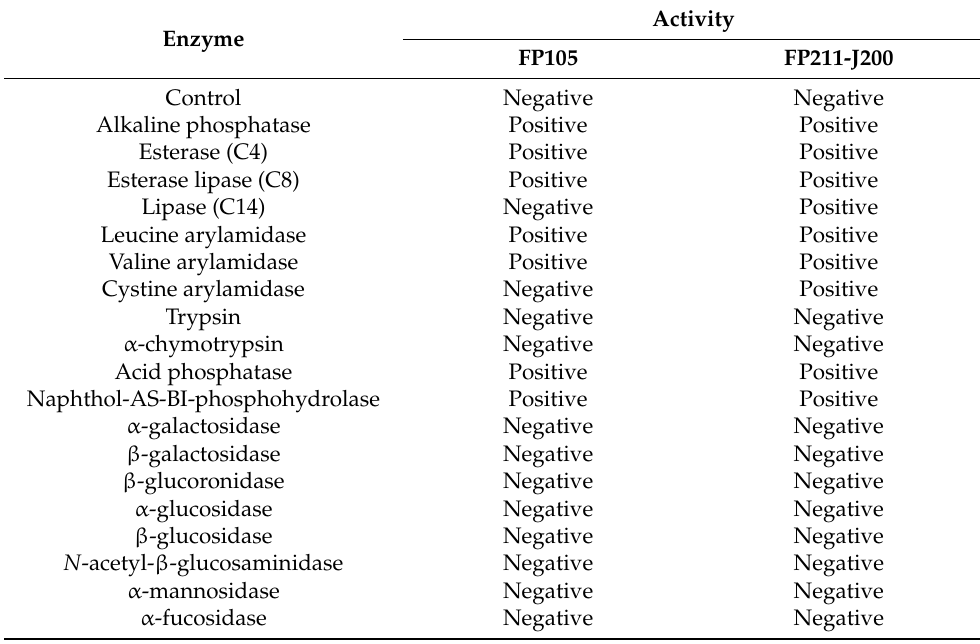
Figure 1. Colony morphotypes of the Epilithonimonas strains recovered from diseased rainbow trout from Chilean farms grown on TYES agar: ( A ) FP105; ( B ) FP211-J200. The API ZYM profiles of the FP105 and FP211-J200 strains are presented in Table 1, showing the capacity of both isolates to produce the enzymes alkaline phosphatase, esterase (C4), lipase (C8), leucine arylamidase, valine arylamidase, acid phosphatase, and naphthol- AS-BI-phosphohydrolase, whereas only FP211-J200 strain was able to produce lipase (C14) and cystine arylamidase. Table 1. Enzymatic properties of the Epilithonimonas FP105 and FP211-J200 strains by using the API ZYM system (BioMerieux).